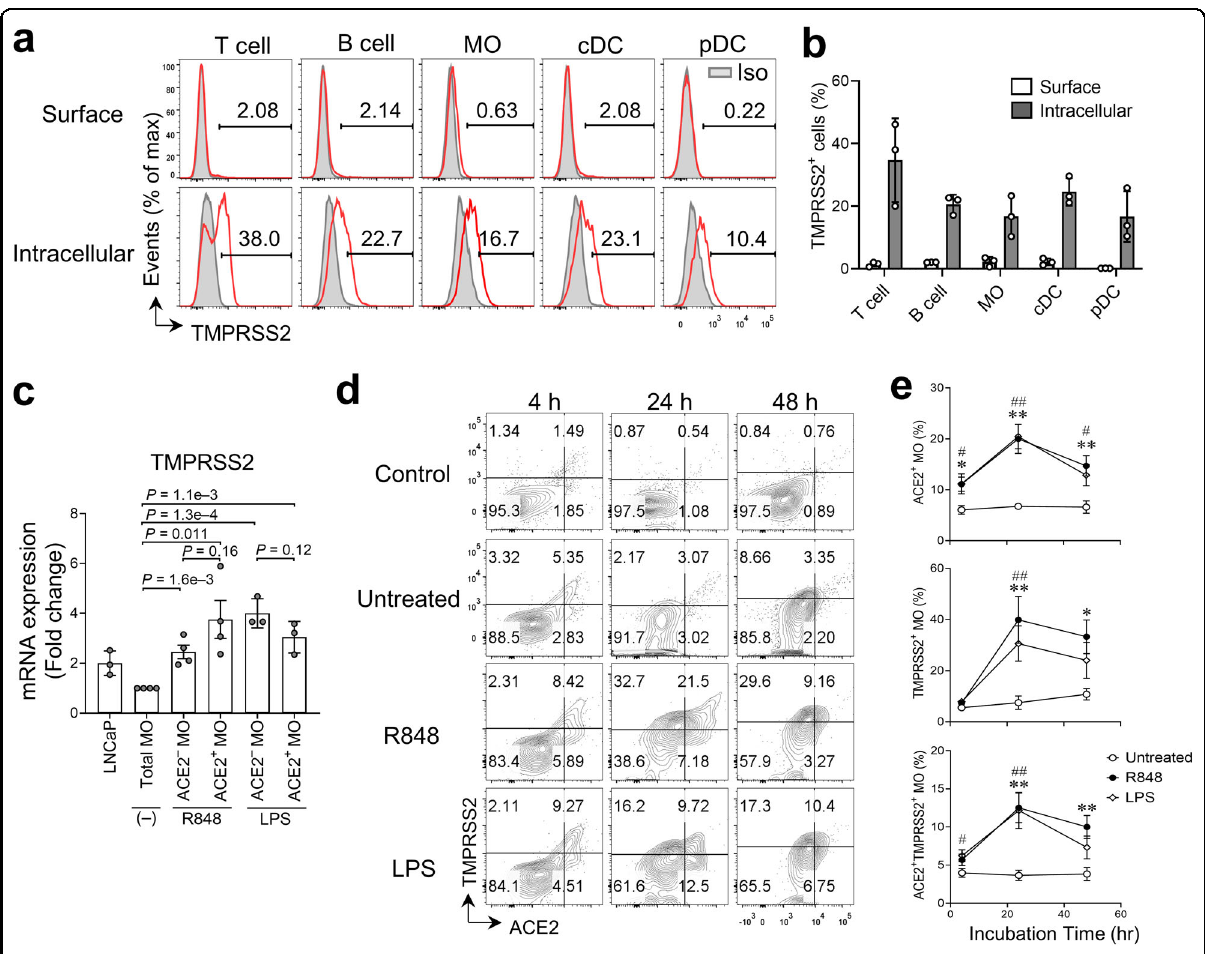
Fig. 3 Concurrent expression of ACE2 and TMPRSS2 on the cell surface of monocytes after TLR4/7/8 stimulation. a Representative fl ow cytometric analysis of TMPRSS2 protein expression (red line) in T cells, B cells, CD14 + MO, cDCs, and pDCs from PBMCs isolated from healthy donors. Mouse IgG1 antibody (gray tinted) was used as isotype (Iso) control. b Frequency of cells with cell surface and cytoplasmic TMPRSS2 expression as in ( a ) ( n = 3 biologically independent samples/group). c Relative TMPRSS2 mRNA expression in indicated cell types compared to expression in total MOs without treatment. ( n = 3-4 biologically independent samples per group). A human prostate adenocarcinoma cell line LNCaP was used as the positive control. d Flow cytometry analysis of ACE2 and TMPRSS2 cell surface expression of CD14 + MO in PBMCs cultured ex vivo with R484, LPS, or medium alone (Untreated) for 4, 24, and 48 h. The expression levels of ACE2 and TMPRSS2 in B cells from the same donor served as the untreated baseline control (Control). e Frequency of ACE2 + MO, TMPRSS2 + MO, and ACE2 + TMPRSS2 + MO for each condition in d . Bars represent means ± SEM of biologically independent samples ( n = 6/group at 4 h and 24 h; n = 5/group at 48 h). * indicates comparisons between R848-treated and untreated groups; # indicates comparison of LPS-treated and untreated groups. * or # , P < 0.05; ** or ## , P <